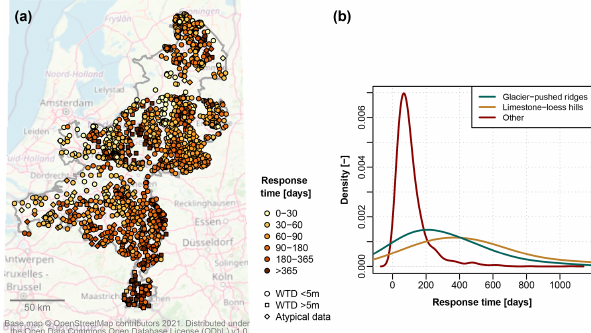
Figure 7. Response time to recharge as derived from the fitted re- sponse functions. See Fig. 1 for the location of